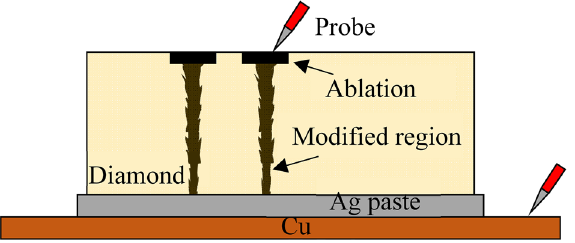
Figure 8. Schematic illustration of a sample conductivity